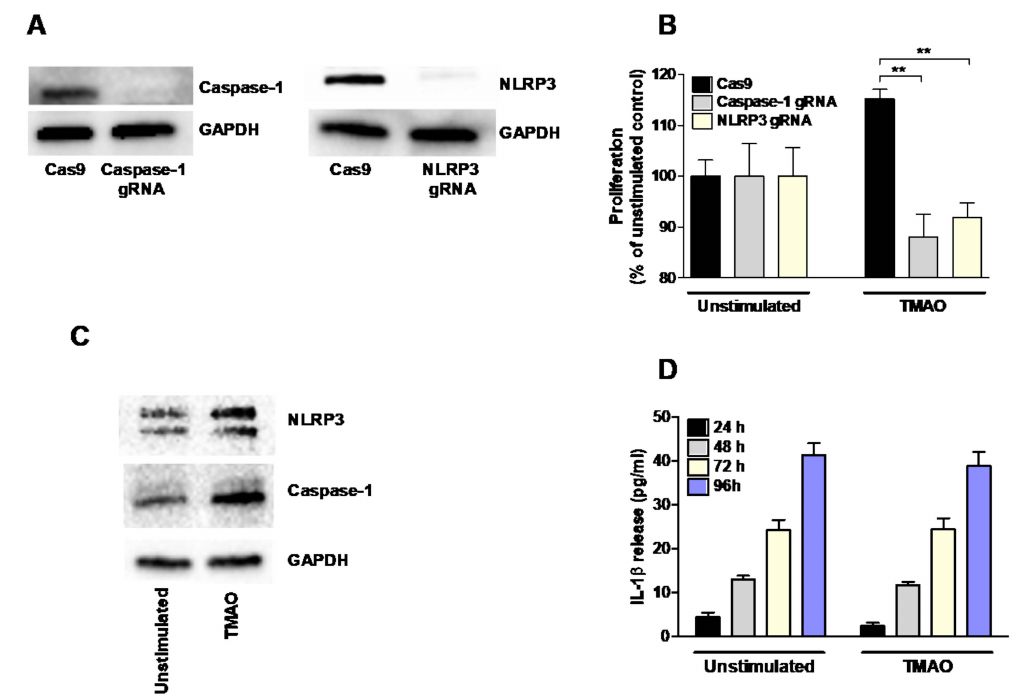
Figure 4. NLRP3 and caspase-1 mediate TMAO’s proliferative effect on renal fibroblasts. NLRP3 and caspase-1 KO CRISPR Cas9 renal fibroblasts were constructed and evaluated by Western blot ( A ). The NLRP3 and caspase-1 KO cells were stimulated with 300 µ M TMAO and the proliferation was assessed after 48 h ( B ). Proliferation is presented as % of unstimulated control. Western blot analysis was conducted to evaluate NLRP3 and caspase-1 levels after TMAO (300 µ M) stimulation for 48 h ( C ). IL-1 β release was quantified from renal fibroblasts following 24–96 h stimulation with TMAO (300 µ M) ( D ). GAPDH was used as a loading control. gRNA stands for guideRNA targeting specific genes using CRISPR/Cas9. Data are presented as mean ± SEM ( n = 3 independent experiments). Asterisks denote statistical significance (** p <